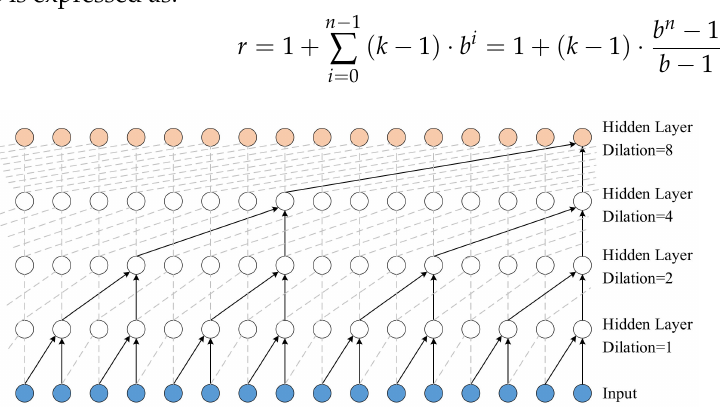
Figure 3. Dilated casual